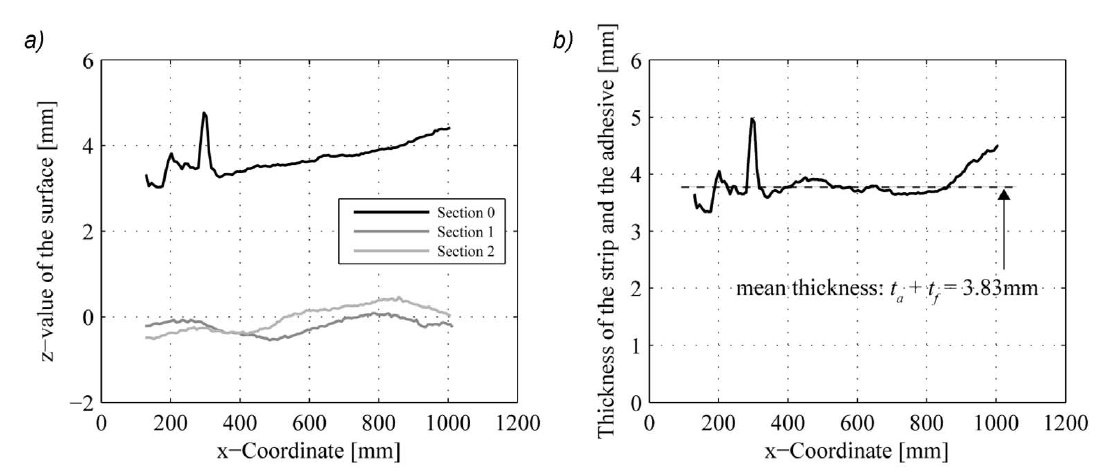
Figure 3. ( a ) The z -value of the surfaces and ( b ) the transformed thickness of the adhesive and CFRP strip.